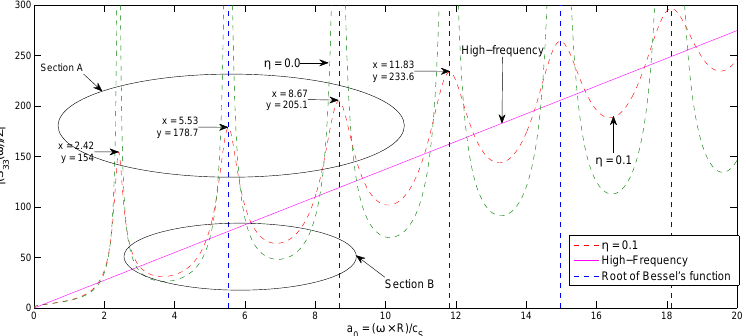
Figure 14. Non-dimensional dynamic stiffness due to high and low frequency vertical load in the axial direction for different values of loss factor η = 0.0 and η = 0.1 when ν = 0.495 and E = 9411